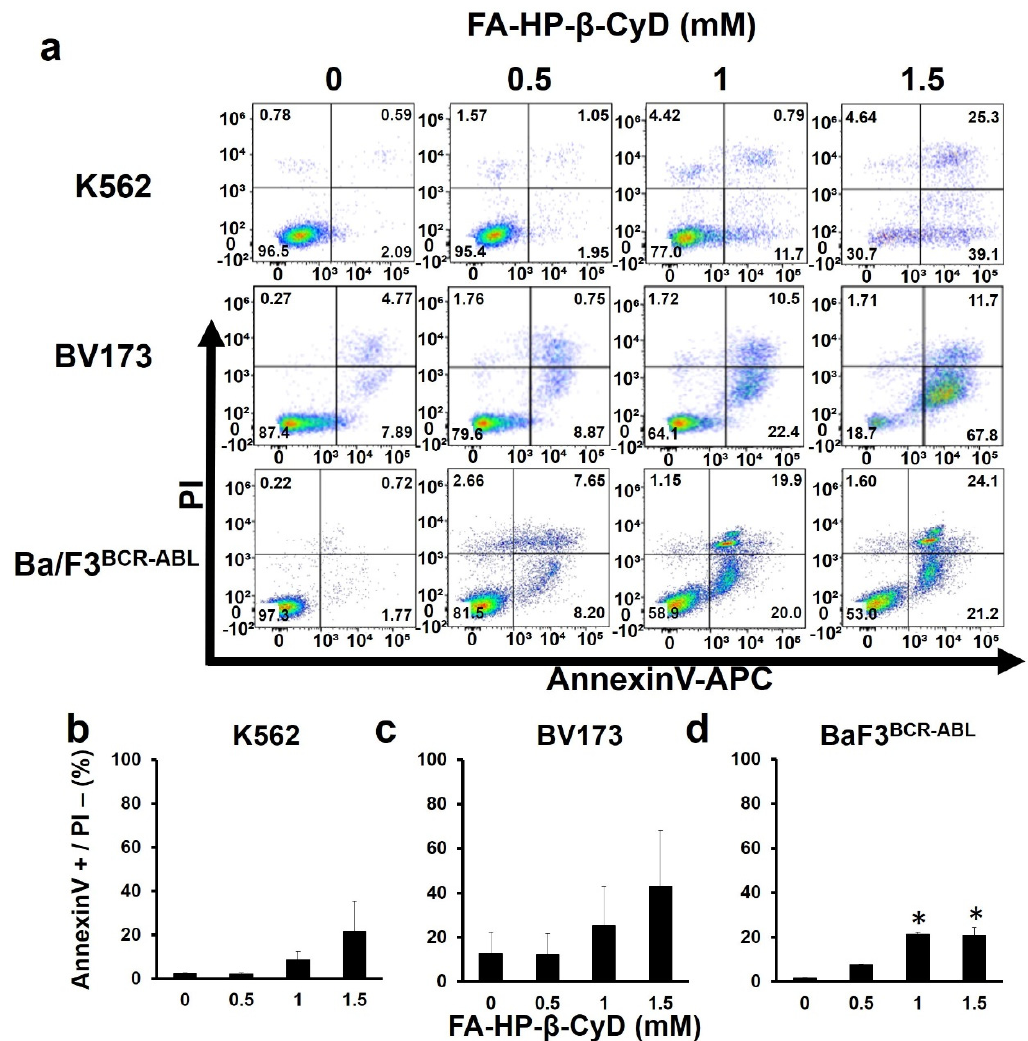
Figure 4. FA-HP- β -CyD induces apoptosis in K562 cells, BV173 cells, and Ba/F3 BCR-ABL cells. ( a ) K562 cells, BV173 cells, and Ba/F3 BCR-ABL cells were treated with 0, 0.5, 1.0, and 1.5 mM of FA-HP- β -CyD. After 72 h of culture, the Annexin V and PI-staining was done. Representative FACS plots are shown ( n = 3). ( b – d ) Percentages of Annexin V-positive PI-negative cells exposed to FA-HP- β -CyD for 72 h are shown. Data represent the mean ± SD of three independent experiments. * p <